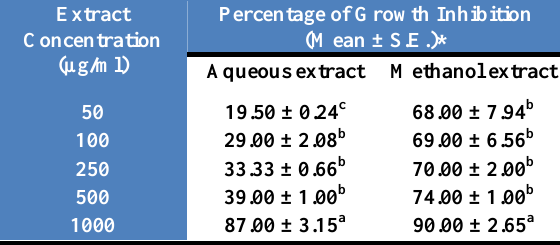
Table, 2: Growth inhibition effects of green tea aqueous and methanol extract on RD cell lines.